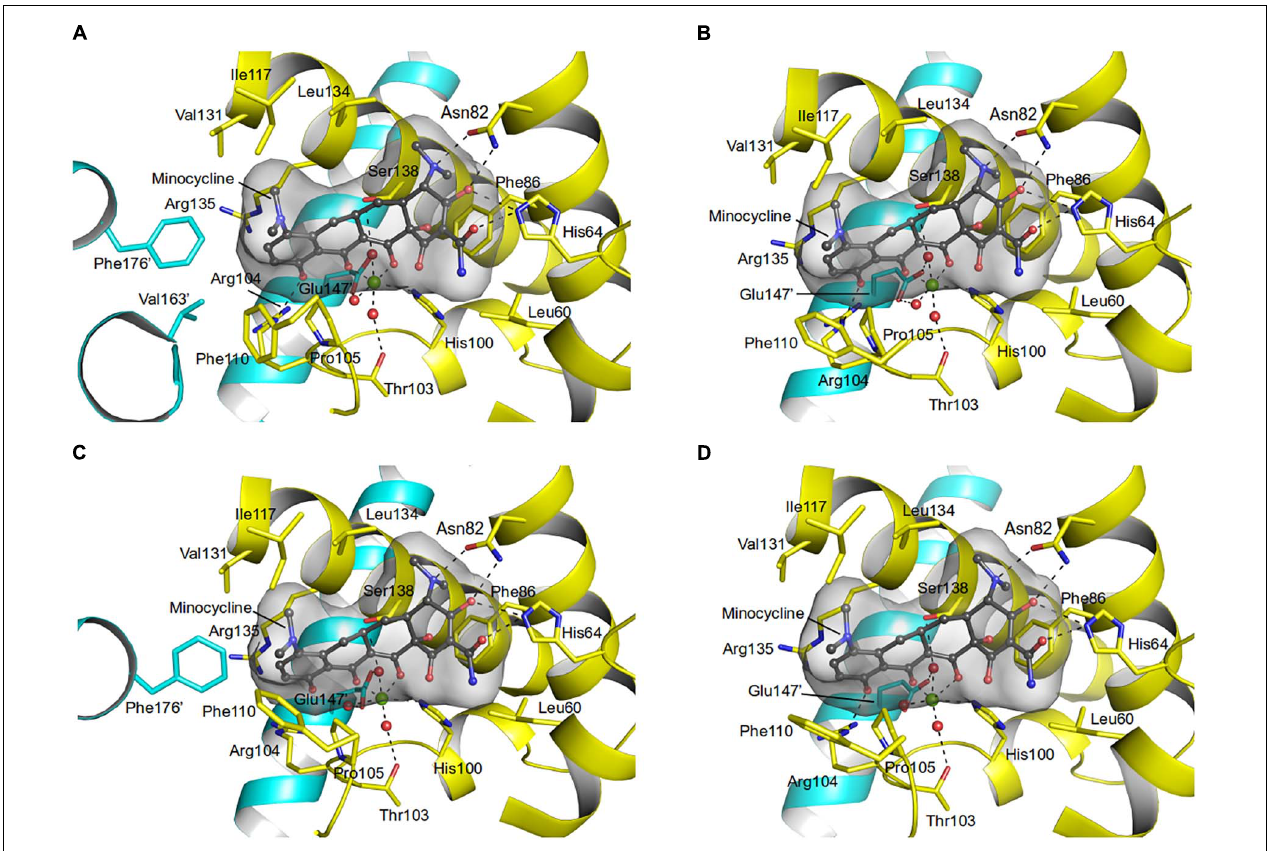
FIGURE 4 | Minocycline binding sites of the AbTetR-Gln116Ala variant. Minocycline bound to (A) Monomer A; (B) Monomer B; (C) Monomer C; and (D) Monomer D. Residues from the symmetry-related protomer are colored in cyan. Water molecules and the Mg 2 + are depicted as red and green spheres,